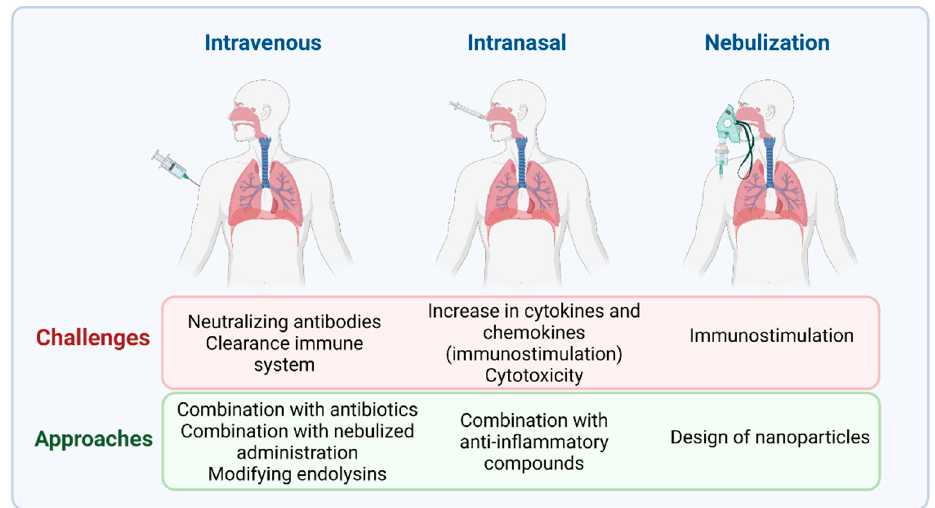
Figure 2. Different possibilities for delivery of phage therapy for the treatment of pneumonia caused by Gram-positive bacteria.